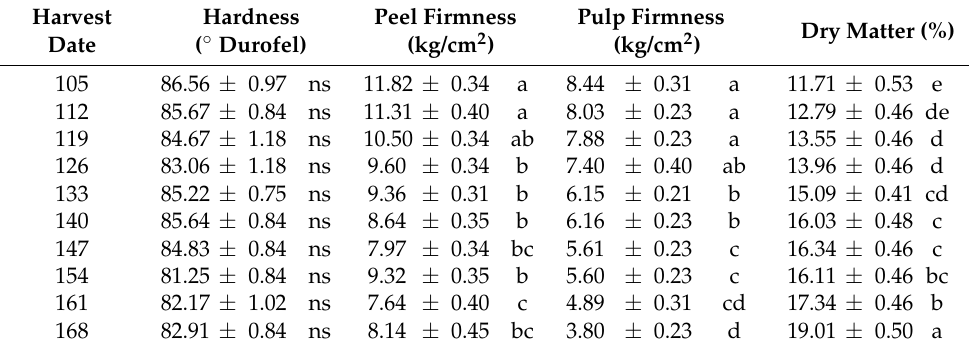
Table 1. Physicochemical parameters of Osteen mango (mean ± SD, n = 3) at harvest date (days after full flowering).